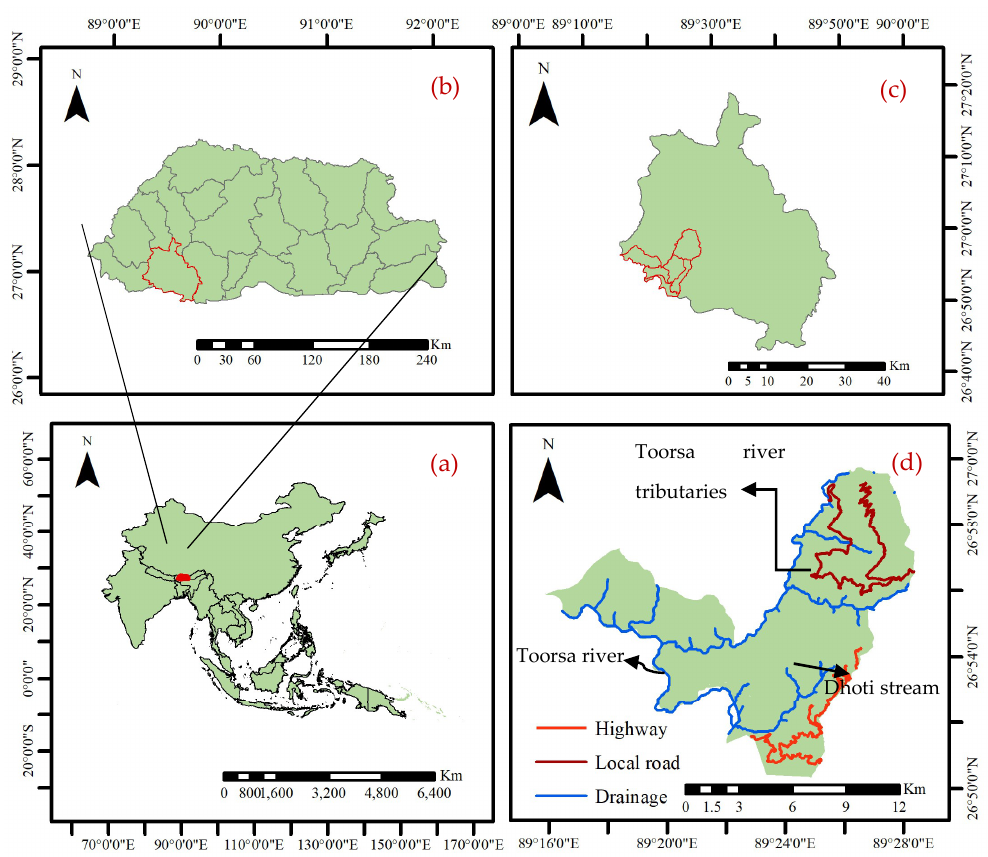
Figure 1. Location of the study region showing ( a ) Bhutan in Southeast Asia, ( b ) Bhutan highlighting Chukha Dzongkhag, ( c ) Chukha Dzongkhag highlighting Phuentsholing region, and ( d ) territorial boundaries of the study region.